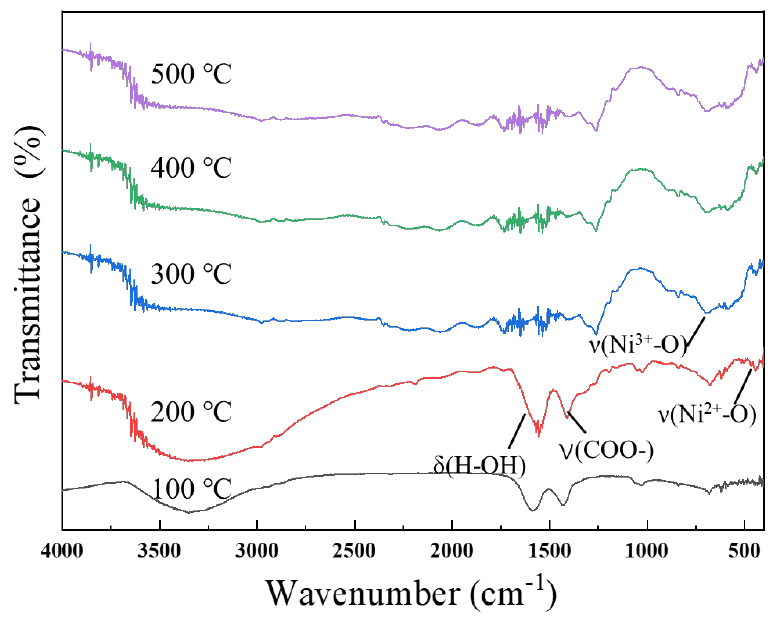
Figure 2. FTIR spectra of NiO films annealed at different temperatures.